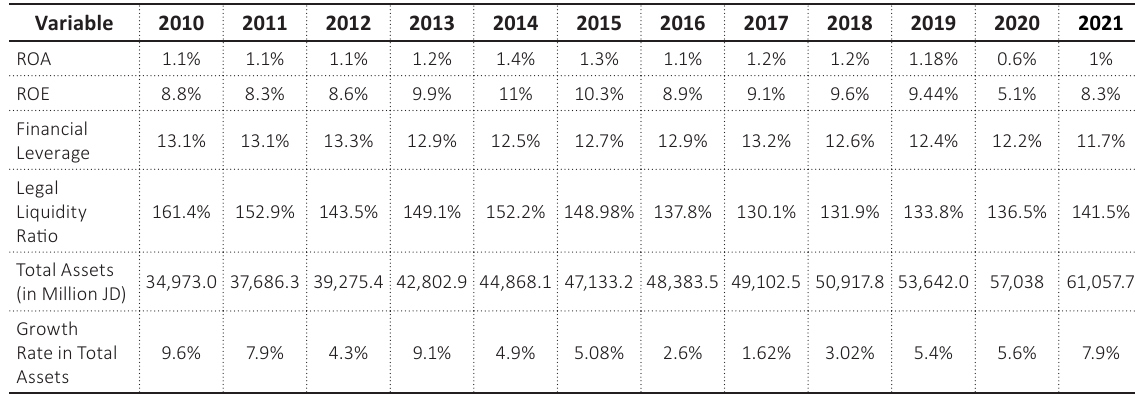
Source: Inter active Database, Central Bank of Jordan.